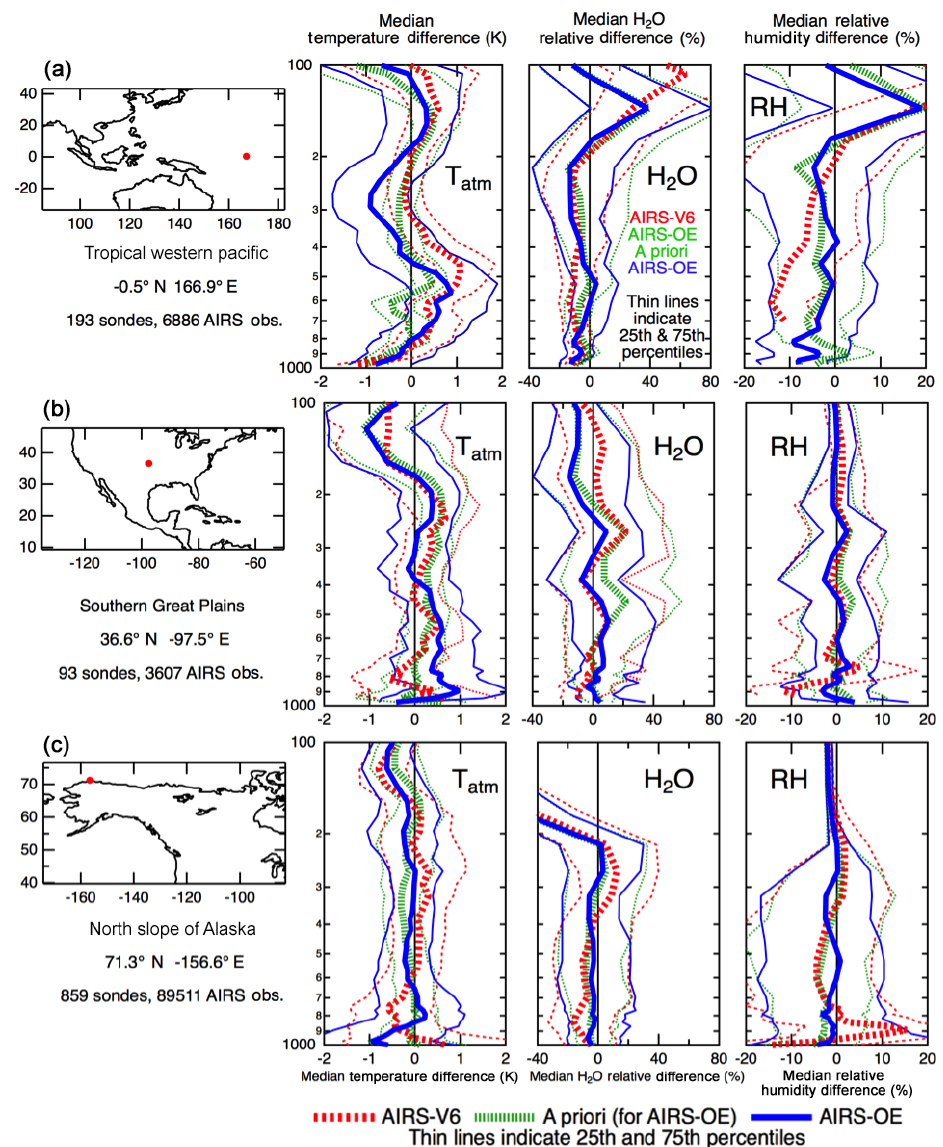
Figure 15. AIRS-OE, AIRS version 6 and (AIRS-OE) a priori profile differences from radiosondes launched from the Tropical Western Pacific site (a) , Southern Great Plains (b) , and Alaska North Slope (c) . Left column: median temperature differences (minus sonde). Middle column: median relative difference in water vapor ([AIRS – sonde]/sonde in %). Right column: median difference in relative humidity (in %). Thin lines represent 25th and 75th percentiles. AIRS observations were within 3h and 100km of sonde launch and only those retrieved layers passing quality control were counted. The a priori profile for AIRS V6 is not shown. See Sect. 5.1 for description of data aggregation before calculation of